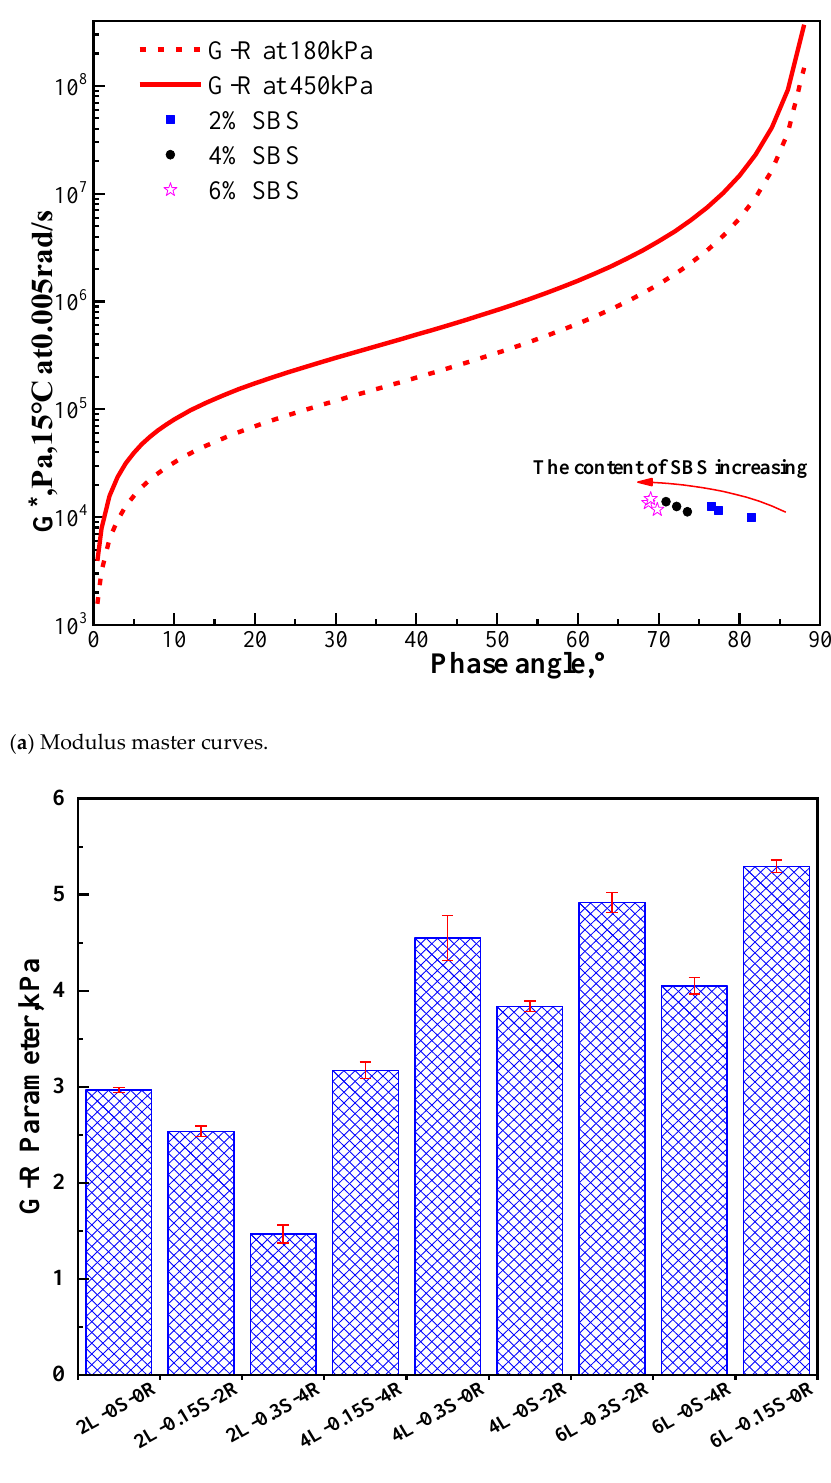
Figure 3. Modulus master curves and testing results of G-R parameter.